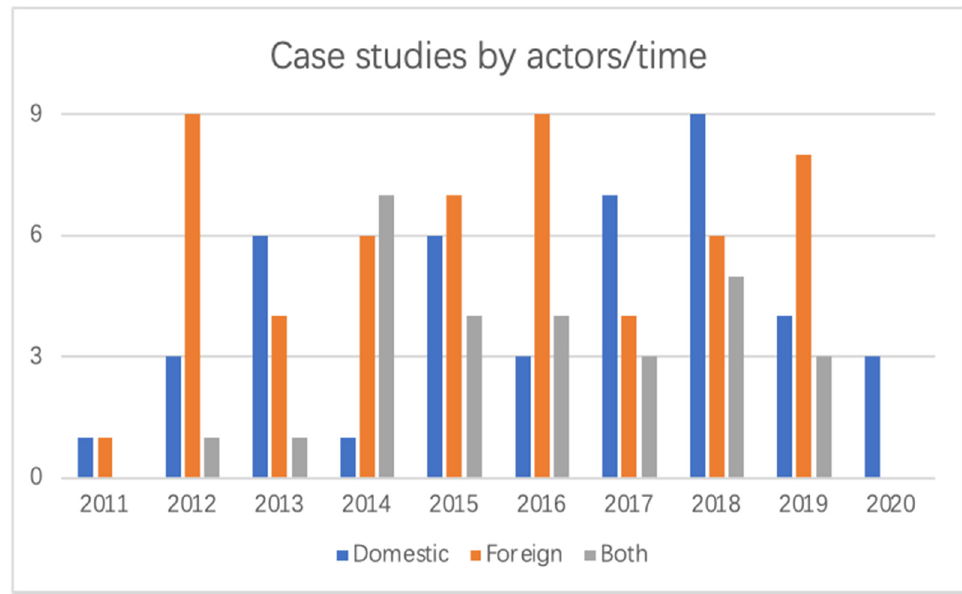
Figure 3. The case studies by actors in different years ( n = 128).